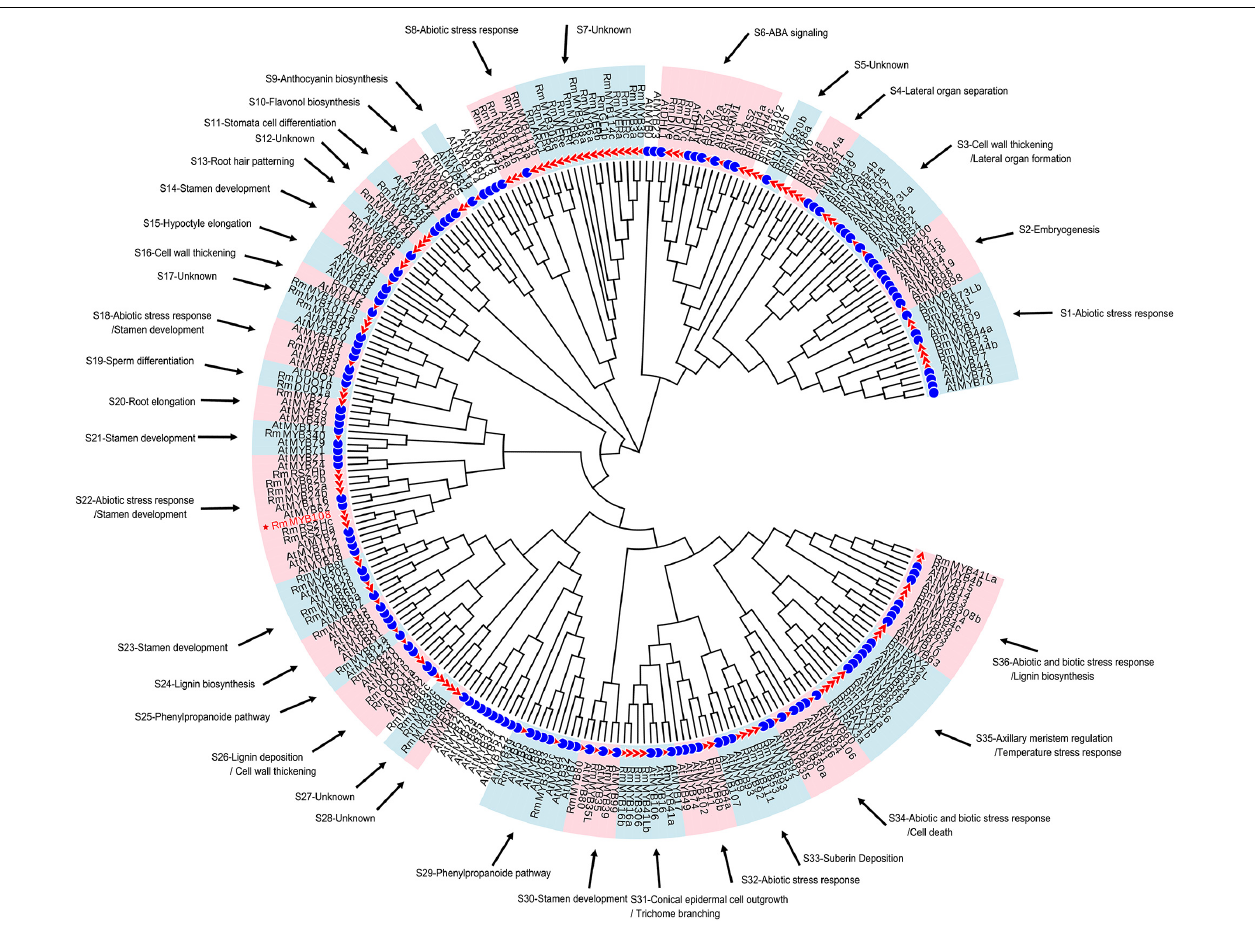
FIGURE 1 | Putative functions of R2R3 - MYB genes in Rosa multiflora based on the cluster results between R. multiflora and Arabidopsis thaliana in the phylogenetic tree. Red triangle marked R2R3-MYBs in R. multiflora and blue circle represented R2R3-MYBs in A. thaliana . The circular unrooted tree was generated by maximum likelihood method. Different subgroups were marked with pink and light blue background, and the function of each subgroup referred the genes with confirmed functions in A. thaliana .